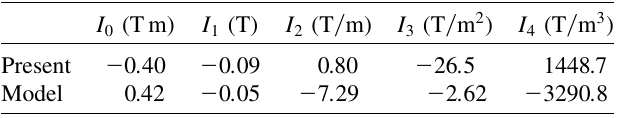
TABLE V. Poles cut around the average beam trajectory in the pole regions (complete model): integrated coefficients of the polynomial expansion of the magnetic field.